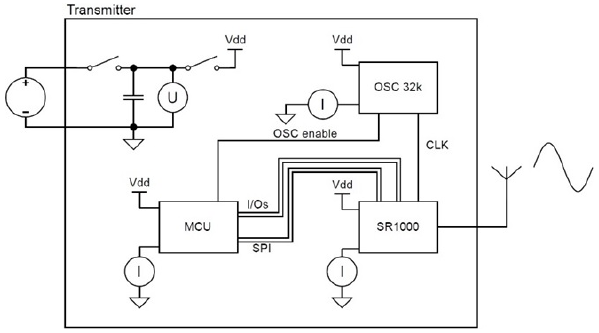
Figure 6. Measurement setup for power and energy